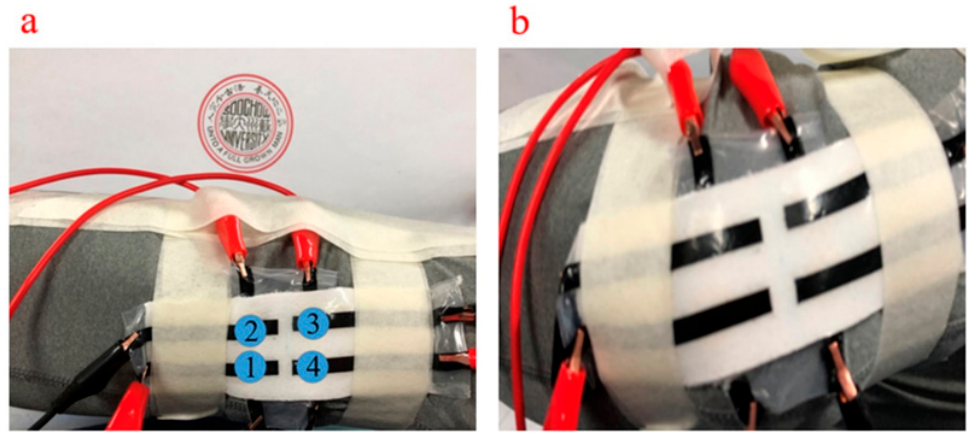
Figure A5. ( a ) Photo of the sensor placed on our elbow. ( b ) Photo of the sensor placed on our elbow under stretching. Figure A6 is a photo of placing of the sensor on the insole we made in this study.